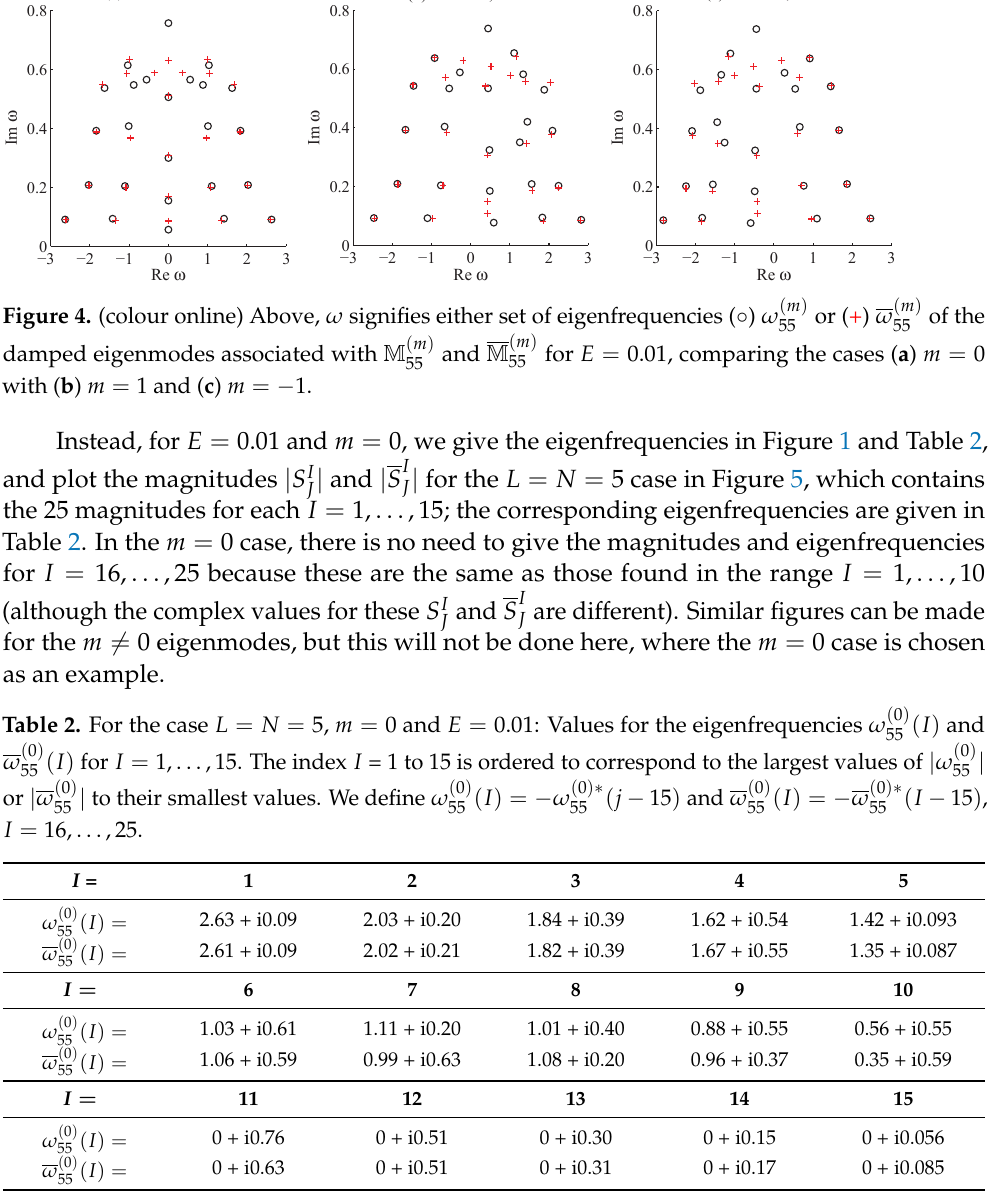
( m ) ( m ) or (+) ω of the 55 55